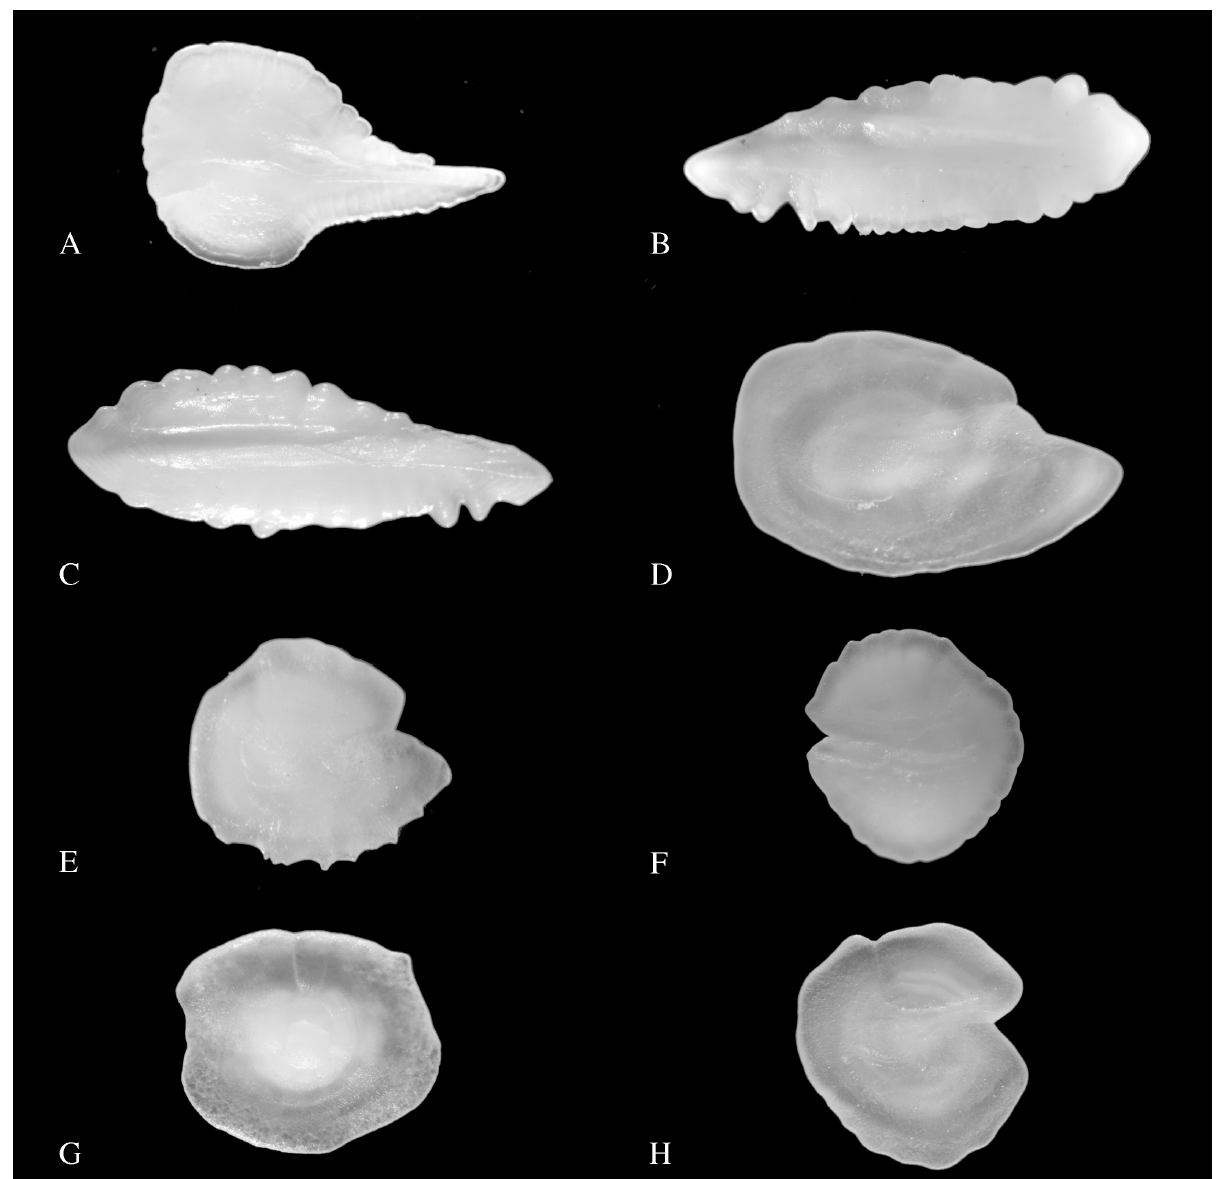
Fig . 2. – A, Gonostoma denudatum (SL = 118.2 mm; W = 8.10 g), left otolith (OL = 4.18 mm; OW = 2.59 mm); B, Microstoma microstoma (SL = 146.0 mm; W = 18.09 g), right otolith (OL = 5.37 mm; OW = 1.92 mm); C, Nansenia oblita (SL = 78.0 mm; W = 4.66 g), left otolith (OL = 4.01 mm; OW = 1.44 mm); D, Ceratoscopelus maderensis (SL = 62.5 mm; W = 2.95 g), left otolith (OL = 2.93 mm; OW = 1.70 mm); E, Diaphus holti (SL = 53.0 mm; W = 2.66 g), left otolith (OL = 3.09 mm; OW = 2.93 mm); F, Electrona risso (SL = 48.5 mm; W = 3.37 g), right otolith (OL = 3.29 mm; OW = 3.64 mm); G, Gonichthys cocco (SL = 45.5 mm; W = 1.10 g), right otolith (OL = 1.27 mm; OW = 1.09 mm); H, Hygophum benoiti (SL = 51.2 mm; W = 2.40 g), left otolith (OL = 1.86 mm; OW = 1.96